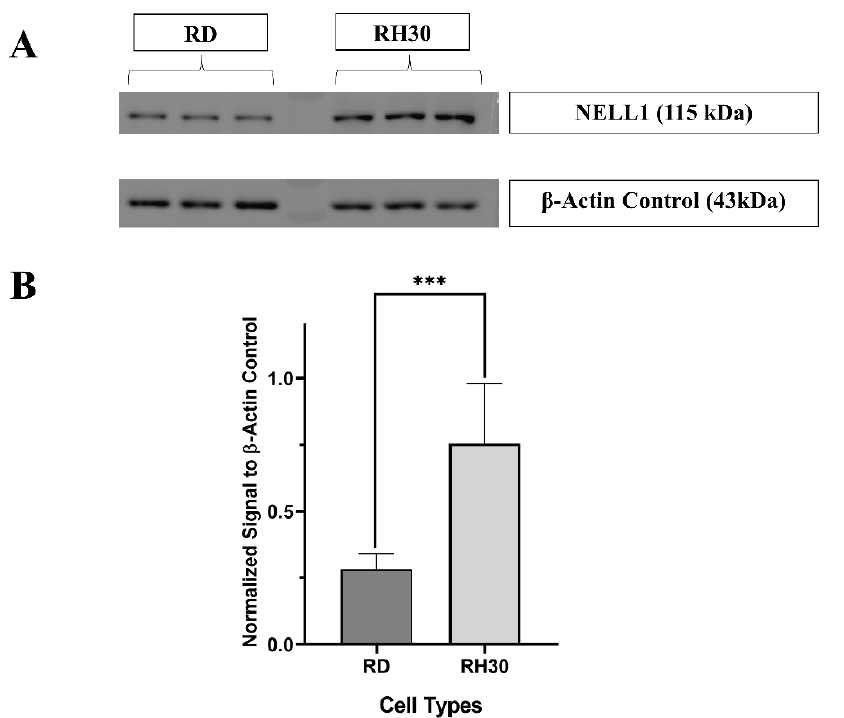
Figure 2. Measurement of NELL1 expression level with Western blotting. ( A ) Representative cropped Western blot comparing NELL1 expression in RD and RH30 sarcoma cells. β -Actin was applied as housekeeping gene control. The densitometry readings of each band (Tables S1 and S2) and uncropped blot (Figure S3) were included in the supplementary materials ( n = 3) ( B ) Quantification of Western blotting showing the β -Actin normalized NELL1 expression level of different cell lines. Data are presented as mean ± SD for each individual cell line ( n = 3). Significance was tested using a two tailed t -test compared to the untreated cells for each cell line (*** p ≤ 0.005).